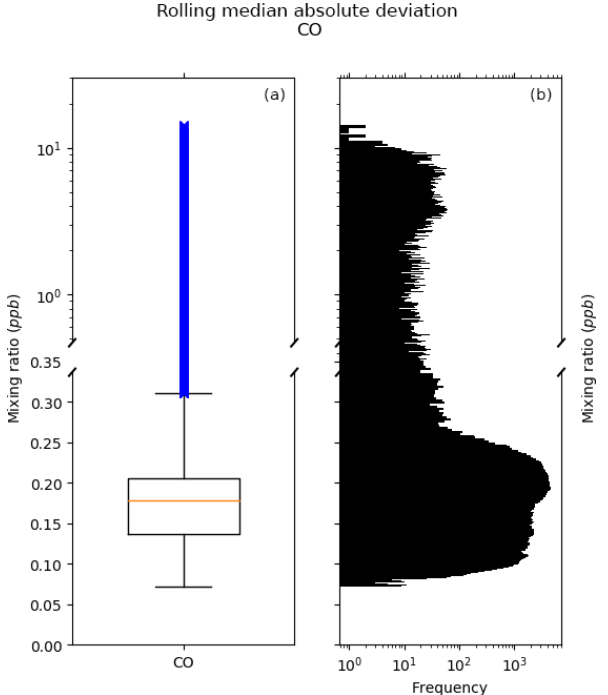
Figure A7. As in Fig. A6 but for CO mixing ratios.